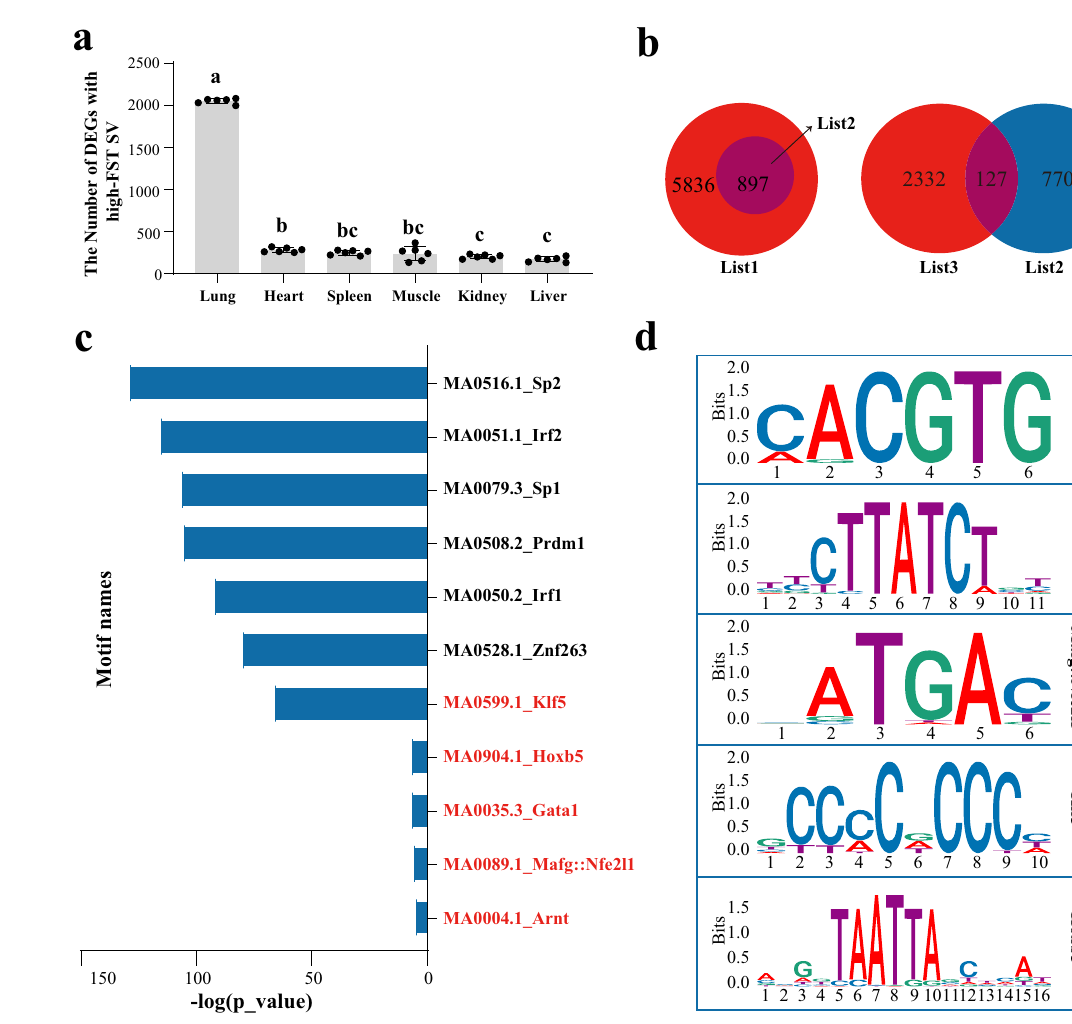
Fig. 2 | Screening of candidate genes in high-altitude adaptation of yak. a The number of DEGs in lung, heart, spleen, kidney, muscle, and liver between taurine cattle ( n =3 biologically independent samples) and yak ( n =4 biologically inde- pendent samples) with high-FST SVs. 5 cattle and 5 yak lung tissue transcriptome datawereusedforanalysis.Differentletters(a,b,c)denotesstatisticalsigni fi cance at P <0.05 (One-way ANOVA with Tukey ’ s test for multiple comparisons; F =1722; P <0.0001). The error bars respectively are 2049.17±28.76, 278.17±24.79,